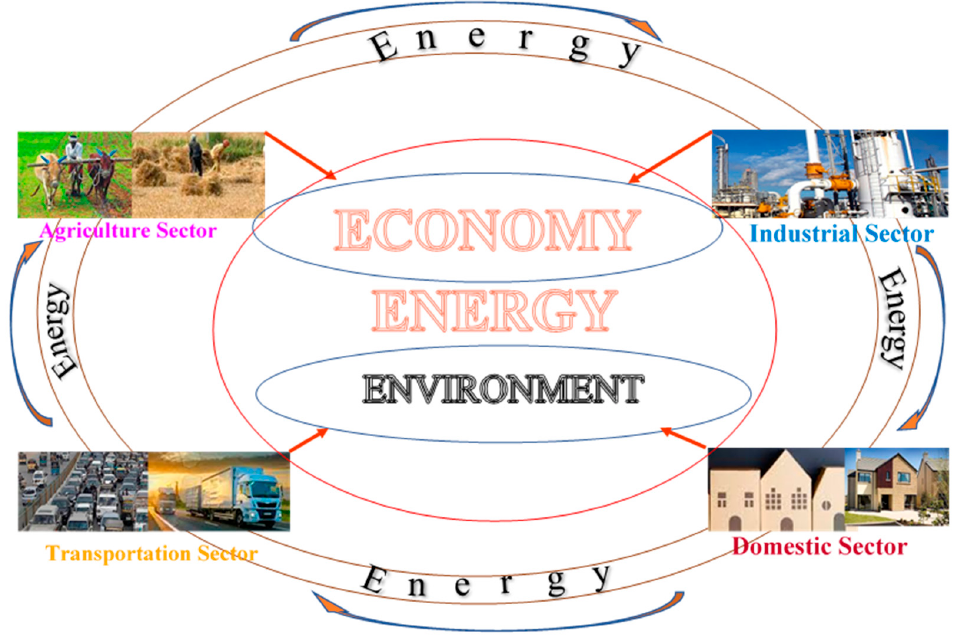
Figure 5. EEE causal nexus at the sectoral level .